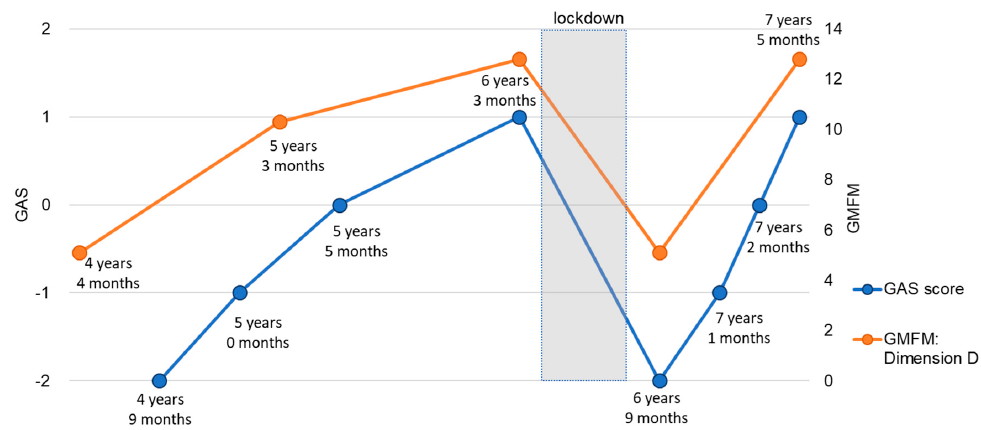
Figure 2. Changes in GAS score and GMFM dimension